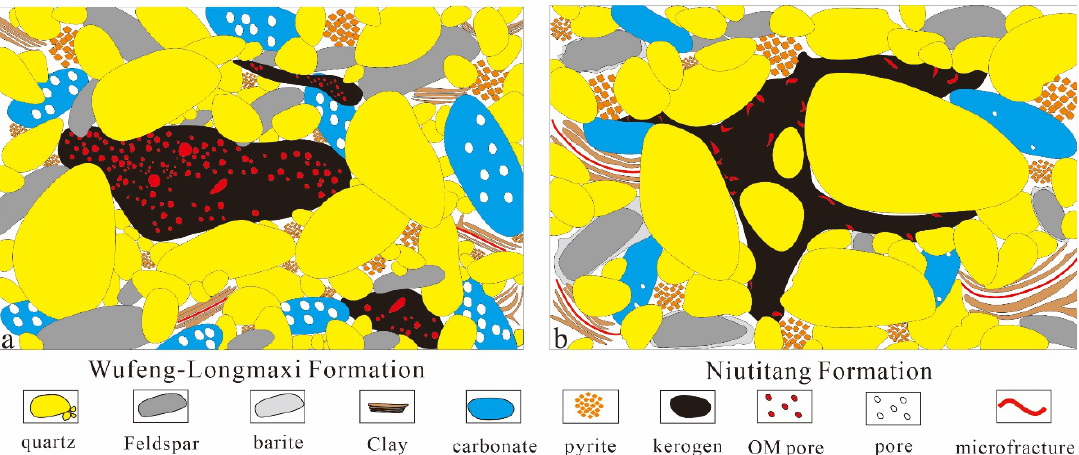
Figure 14. Proposed conceptual model for elaborating differential reservoir-forming mechanisms for the Lower Paleozoic Wufeng-Longmaxi and Niutitang Formations. ( a ) Wufeng-Longmaxi Formation; ( b ) Niutitang Formation.